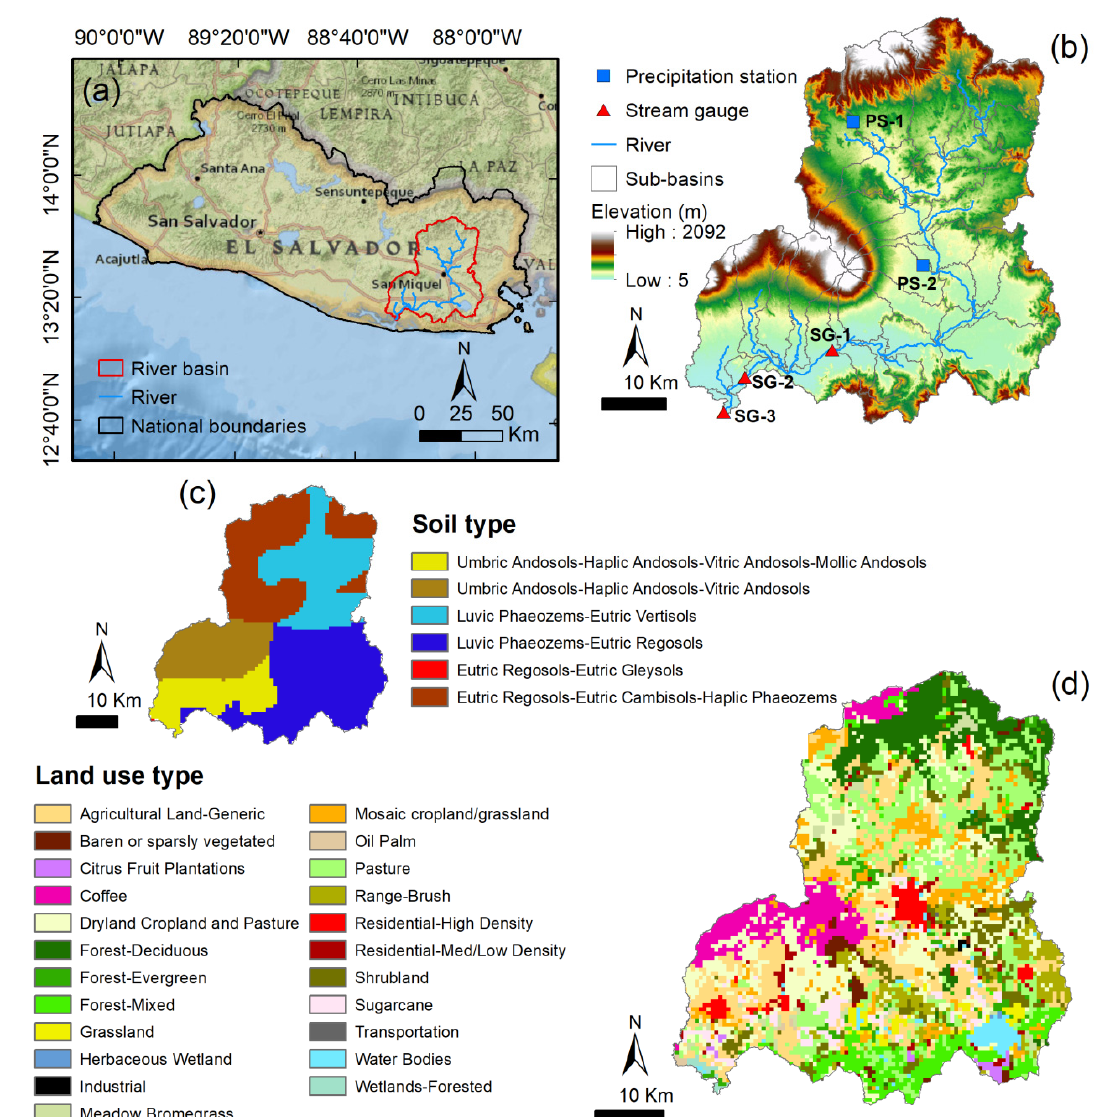
Figure 2. ( a ) Location of GSM River Basin in El Salvador; ( b ) topography of the basin and location of hydro-meteorological stations; ( c ) soil map of the basin and ( d ) land use map of the basin. While the region has a tropical climate with high annual rates of precipitation, the intra-annual distribution is uneven. Specifically, 90% of the precipitation falls during the wet season between May and October, and only scattered showers occur during the dry season between November and April [27,48]. According to observations of the weather stations and the GP analysed, the mean annual precipitation is around 1700–2000 mm, which is consistent with previous studies [48]. The wettest months are August and Sep- tember, with average monthly rainfall values of 290 and 298 mm. January and February have the lowest rainfall, with an average monthly rainfall of 2 mm. The average annual temperature in the basin is 28 °C, with maximum and minimum values of 33 and 22 °C, respectively. The dominant soil groups in the region are classified as andosols, phaeo- zems, and regosols (Figure 2c). The andosols that cover the area associated with the San Miguel volcano are volcanic soils and have favourable properties for agriculture [49]. The dominant soil types at the northern boundaries are regosols, unconsolidated materials with fine granulometry common in mountainous areas, whilst throughout the eastern part of the basin, phaeozem soils are abundant and accommodate wet grasslands and for- est regions as they are characteristically porous, fertile, and excellent agricultural land [50]. Regarding the basin hydrogeology, previous studies [51] indicate high permeability,